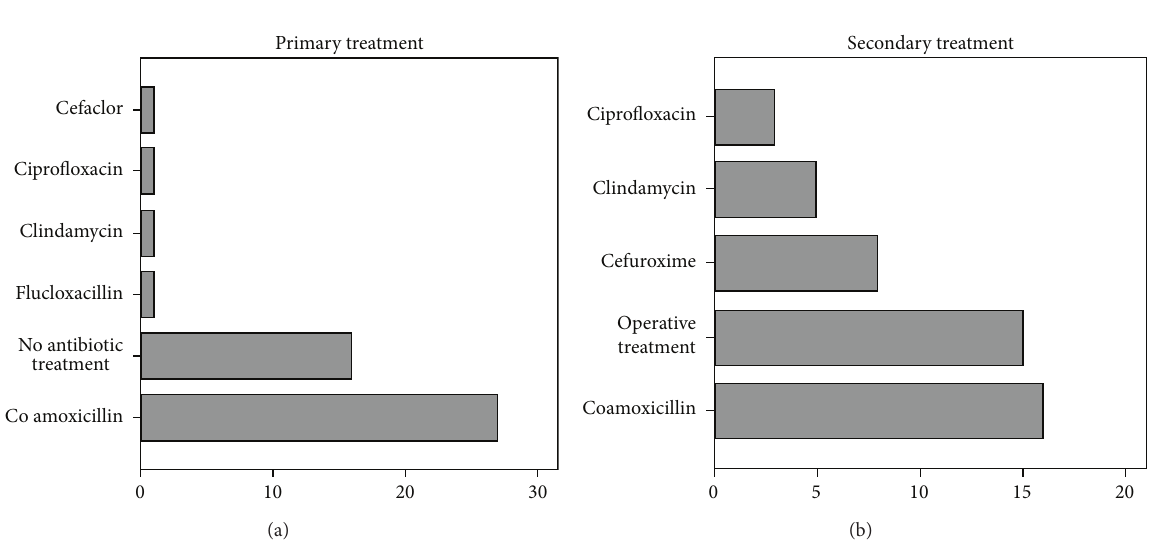
Figure 2: Treatment of patients with secondary presentations: primary (a) and secondary (b) antibiotic